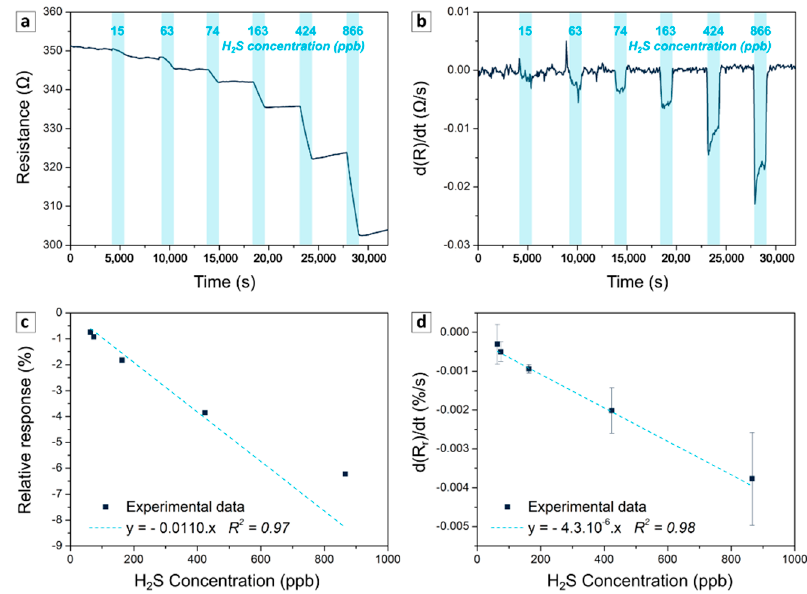
Figure 5. Response to hydrogen sulphide of sensor containing 3 wt% of PEDOT:PSS. Evolution of the resistance ( a ) and its derivative ( b ) as a function of time during cycles with increasing concentrations of hydrogen sulphide, from 15 to 866 ppb. Corresponding calibration curve expressed as the variation of the relative response ( c ) and the mean of its derivative ( d ) as a function of the concentration of hydrogen sulphide.